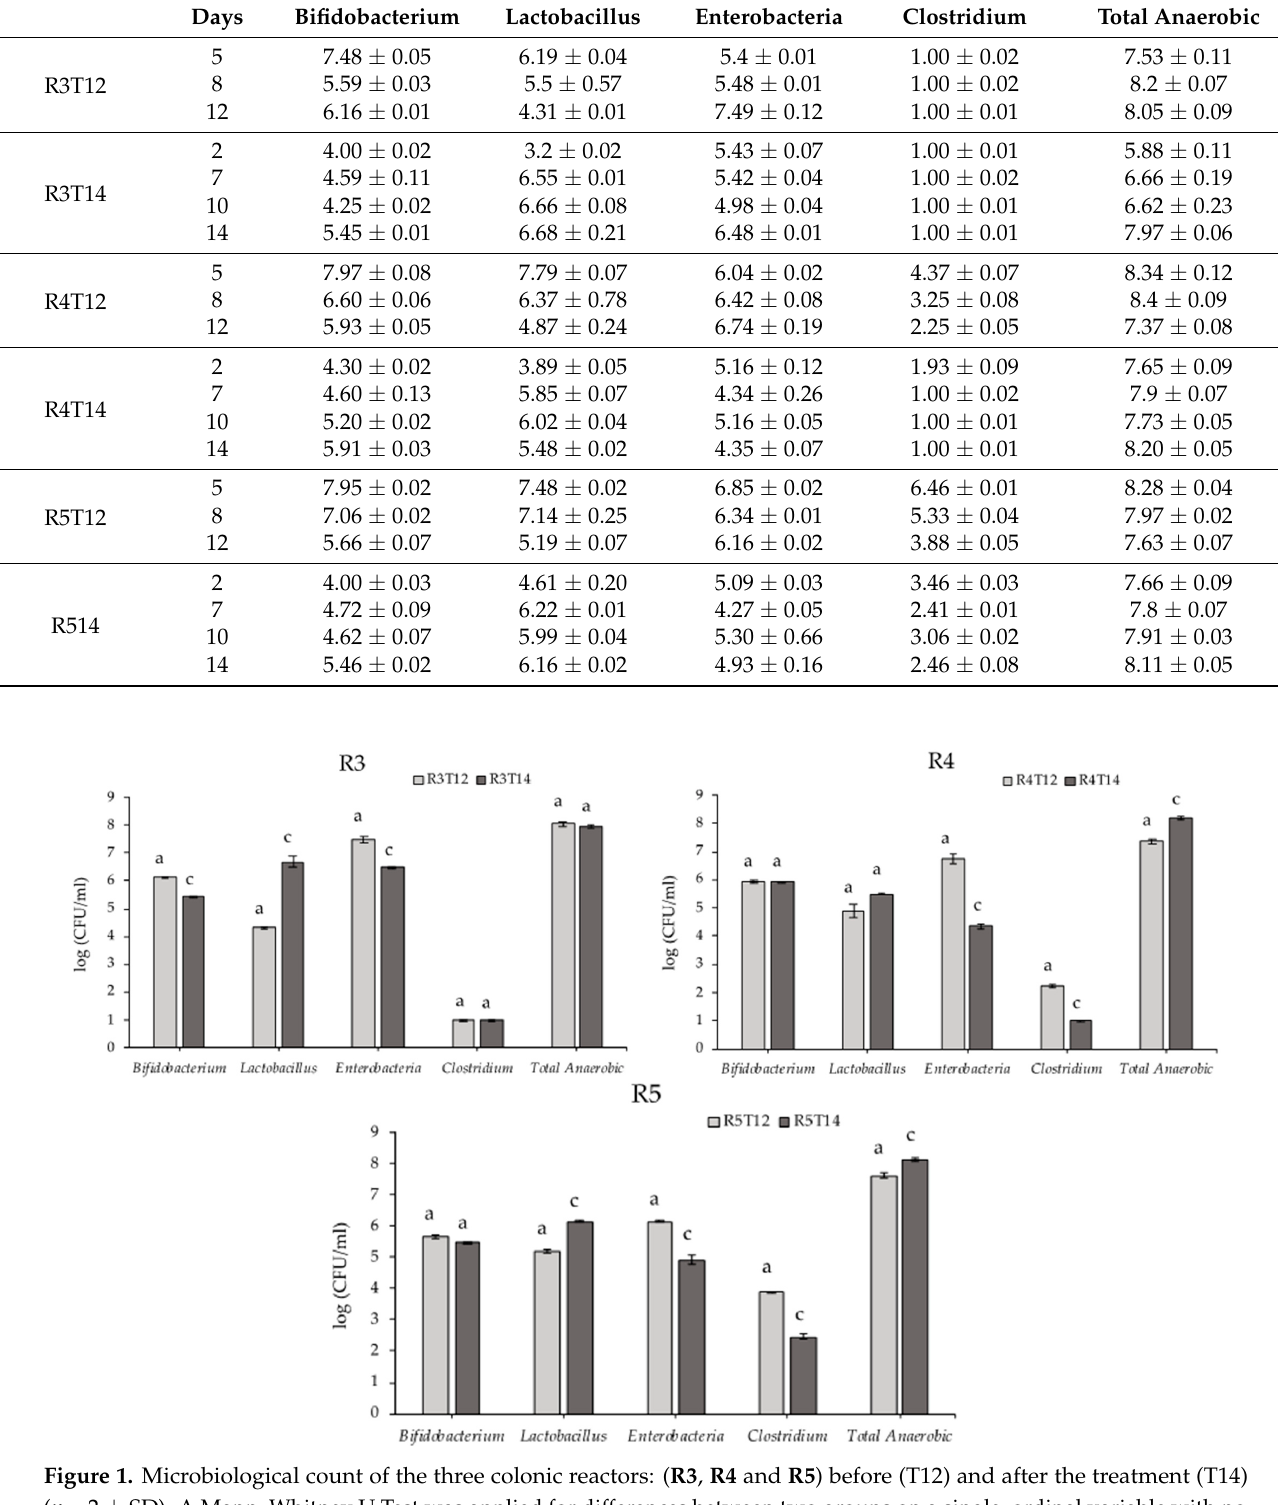
Table 1. Microbiological count of the three colonic reactors during the fermentation of the vegetable drink. R3T12 represents the end of the stabilization period and R3T14 the end of the treatment period. Results are shown as log (CFU/mL).